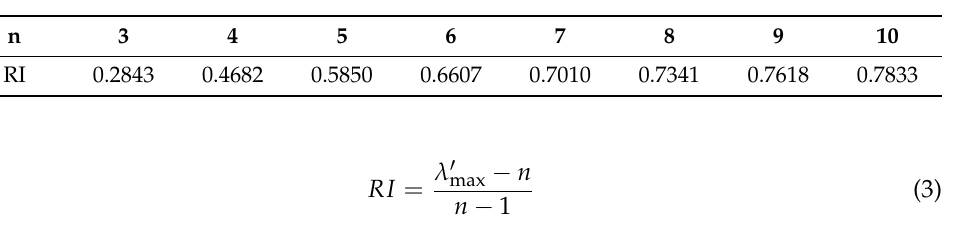
Table 4. The value of RI